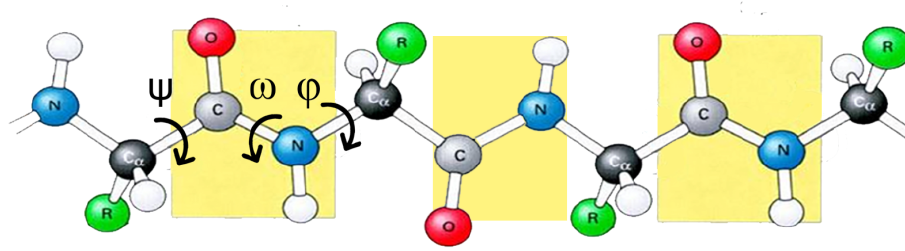
Figure 4. Dihedral angles between the atoms along the backbone of peptide chain.